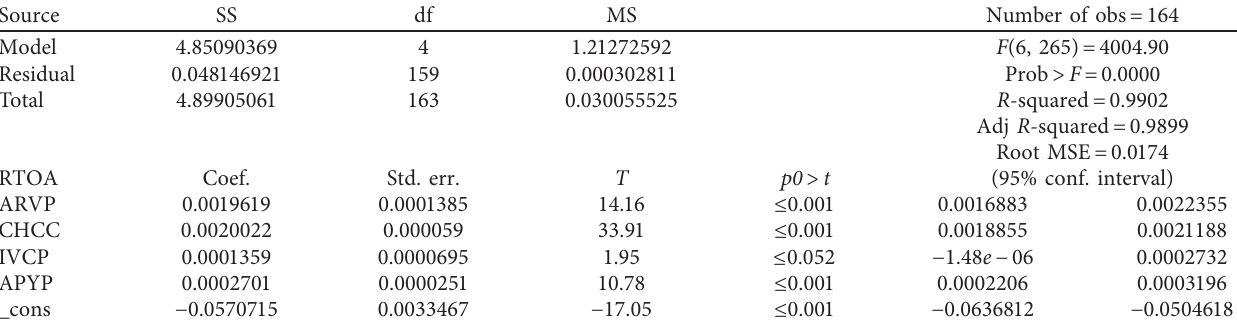
Table 4: Regression result model one (RTOA).